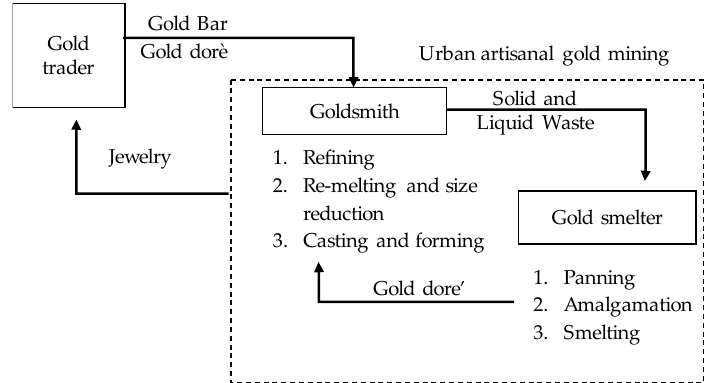
Figure 2. The urban artisanal gold mining process. Relationships between gold traders, goldsmiths, and gold smelters.